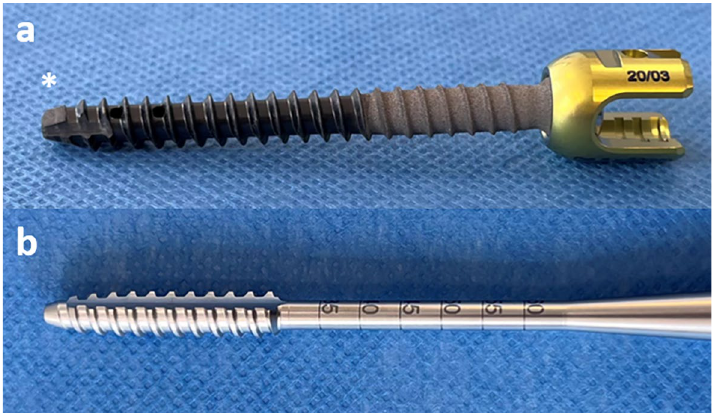
Figure 1. ( a ) Illustration of a 6.5 mm CFRP pedicle screw and ( b ) the corresponding screw tap showing the surface structure and design of the screw head (asterisk) and tap threads (BlackArmor, Icotec, Altstätten,